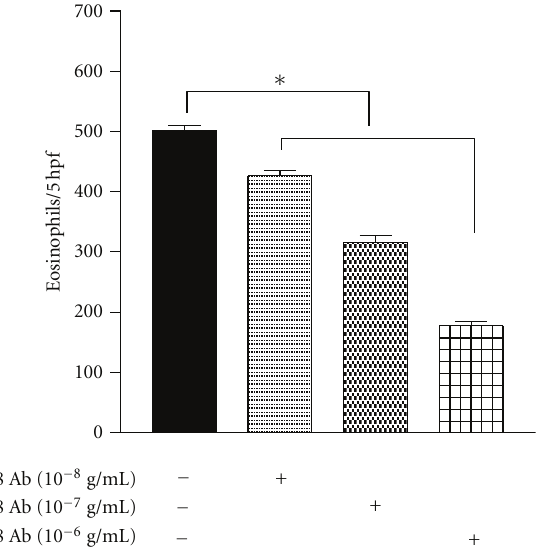
Figure 2: E ff ect of neutralizing IL-8 antibody on eosinophils chemotaxis against IL-15-induced NK cells supernatants. Results are the mean ± SEM of 6 independent experiments performed in triplicate. Asterisk indicates P < 0 . 05 by paired t -test.